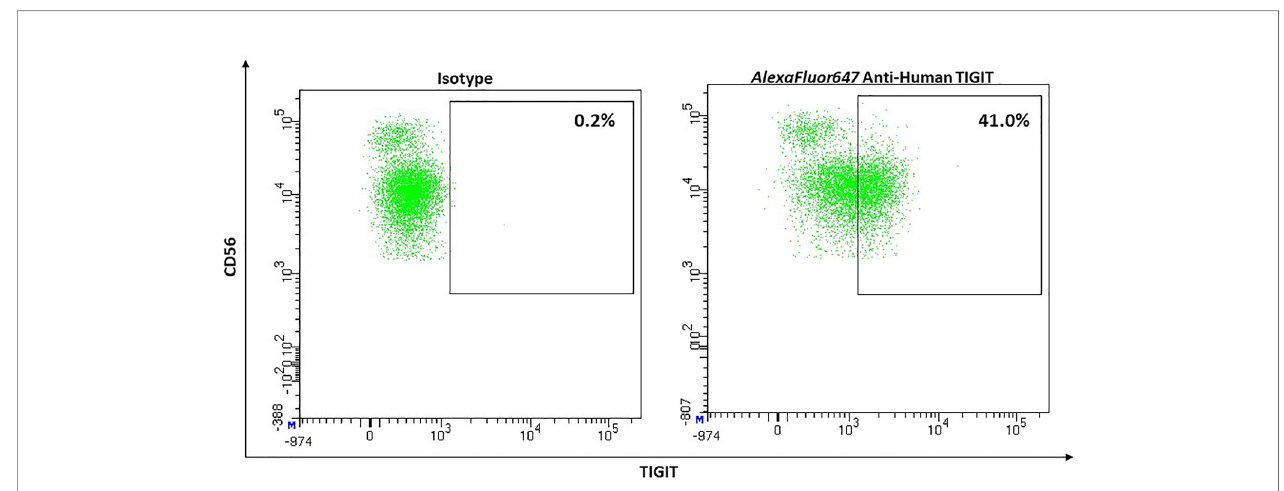
FIGURE 11 | Representative fl ow cytometric analysis of the expression of the immune checkpoint TIGIT on resting NK cells of a healthy donor (male, 23 years old) compared with isotype